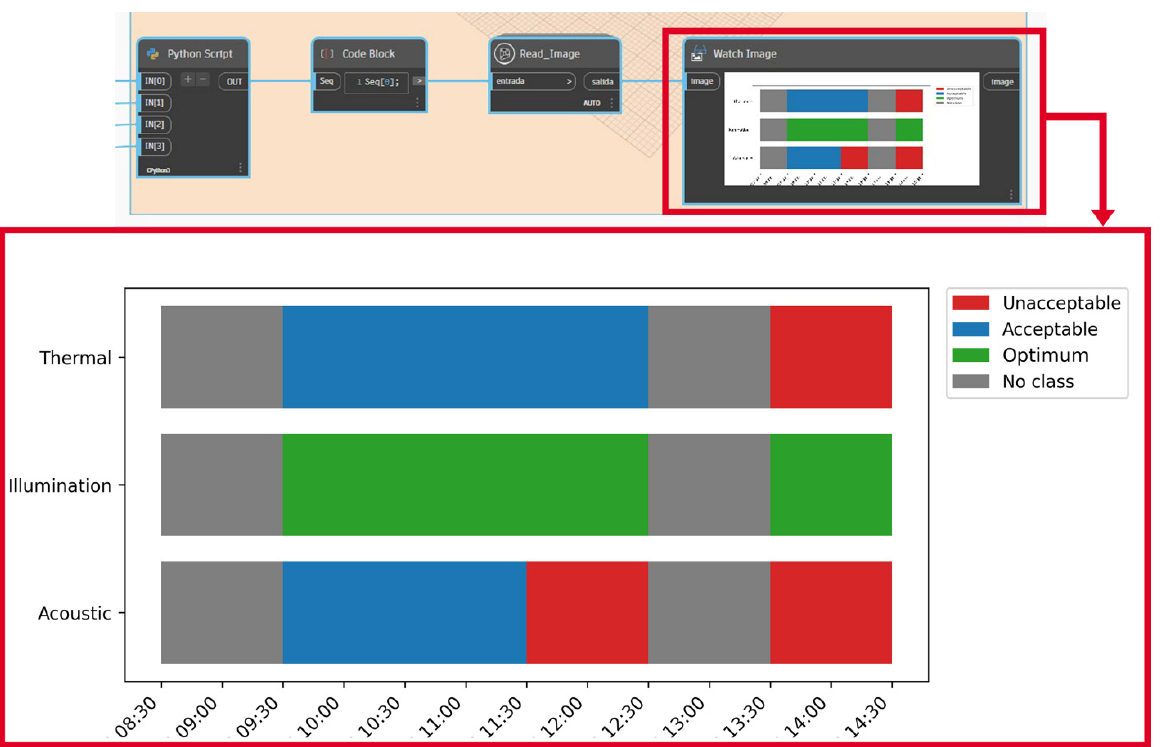
Figure 8. IEQ evaluation results of classroom 110.